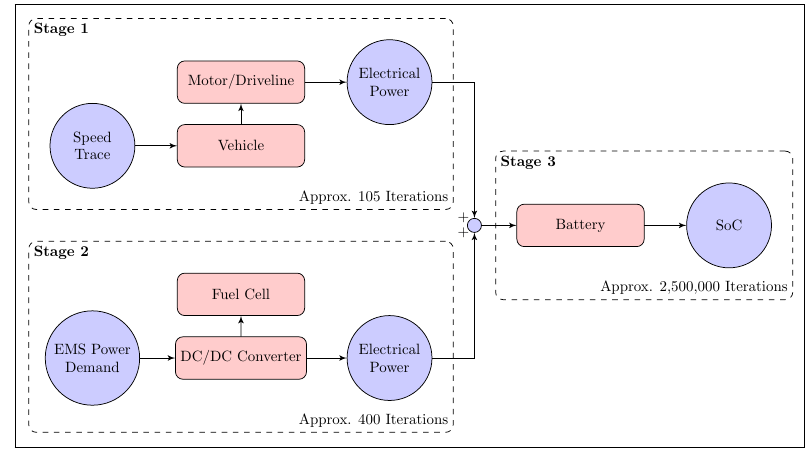
Figure 3. Flowchart of the simulation Figure 1: Flowchart of the procedure used to generate a real-time controller